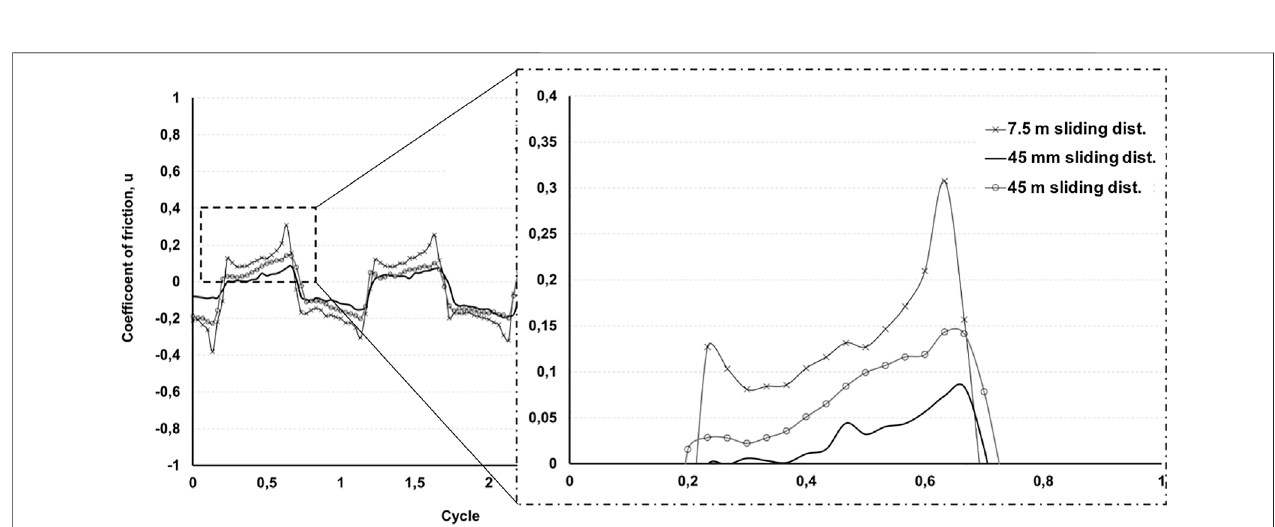
FIGURE 11 | The presence of graphene in the lubricant provides a “ healing ” effect to the tribo-pair; friction increases at fi rst but decreases again in the long run.